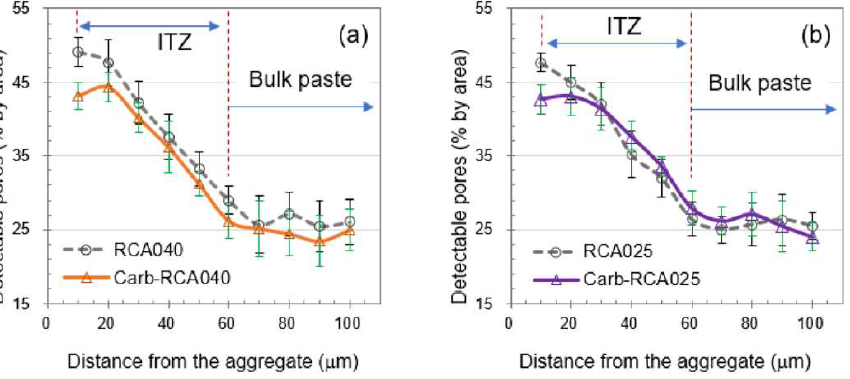
Figure 7. Porosity of ITZ at different distances from the aggregate [38]: ( a ) RCA040 and carbonated RCA040; ( b ) RCA025 and carbonated RCA025. Reproduced with permission from [38], Elsevier, 2020.